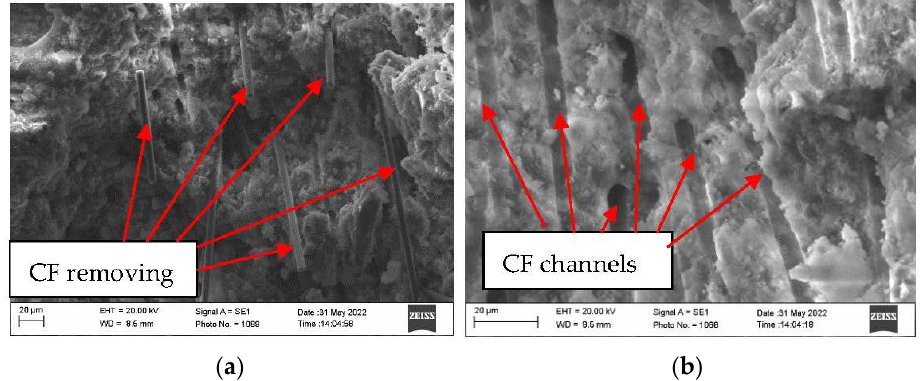
Figure 15. The CF “removal” from cement matrix due to mechanical effect in samples after fire tem- perature effect: ( a ) CF residue, ( b ) remaining channels after CF removal. temperature effect: ( a ) CF residue, ( b ) remaining channels after CF